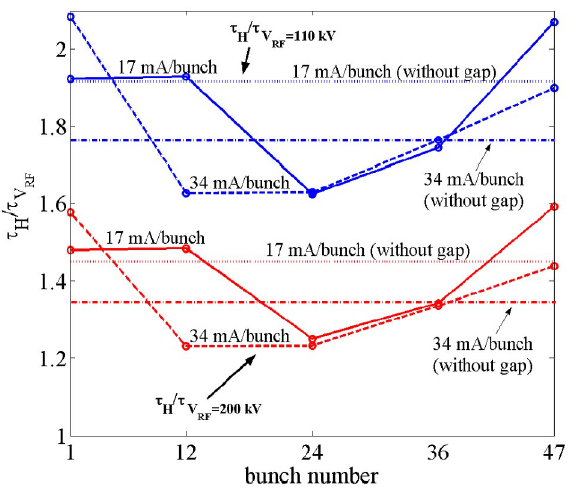
FIG. 14. (Color) Coherent CB mode frequencies and growth rates vs beam current, % n (cid:4) 2 : 5